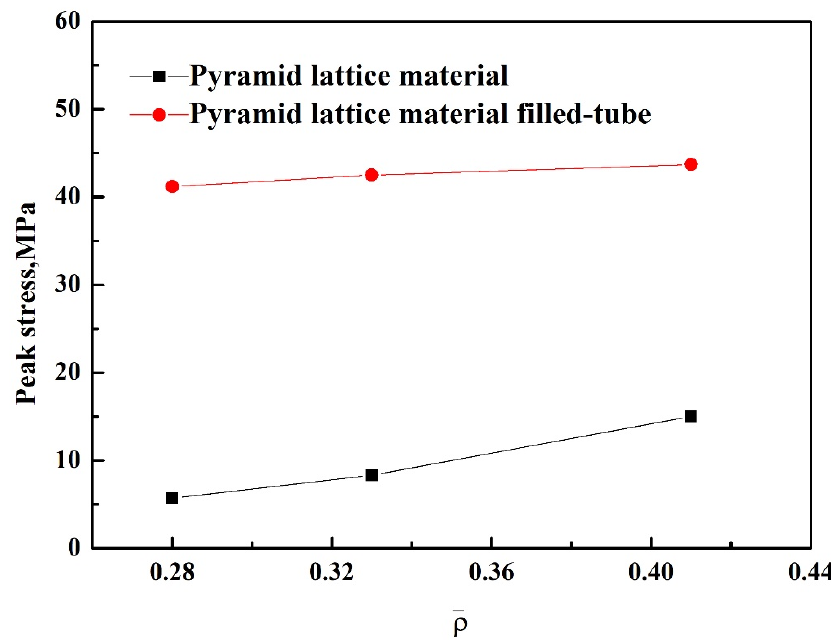
Figure 6. Peak stress of the pyramid lattice material and pyramid lattice material-filled tube with different relative densities.